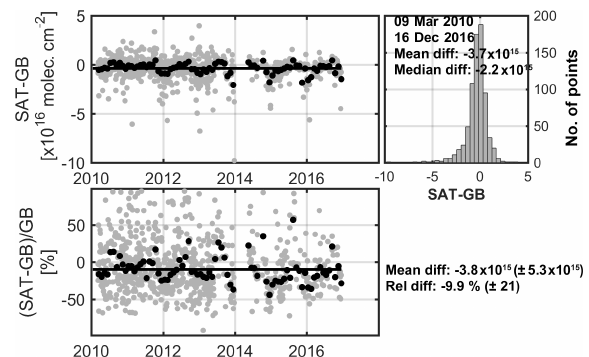
Figure 21. Daily (grey dots) and monthly mean (black dots) abso- lute and relative GOME-2 (SAT) and MAXDOAS (GB) time series differences for Xianghe station. The histogram of the daily differ- ences is also given, showing the mean and median difference. The total time series of absolute and relative monthly differences are given in the bottom-right